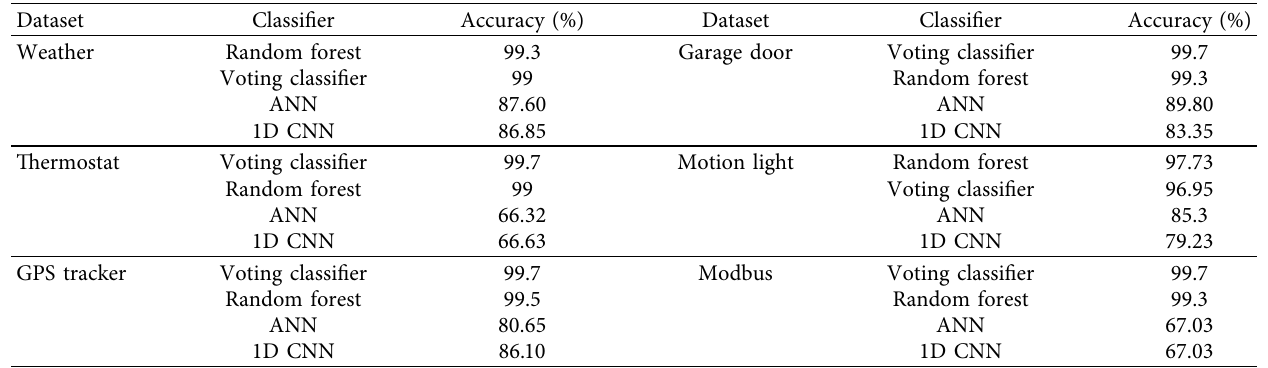
Table 7: The accuracy obtained on each classifier.